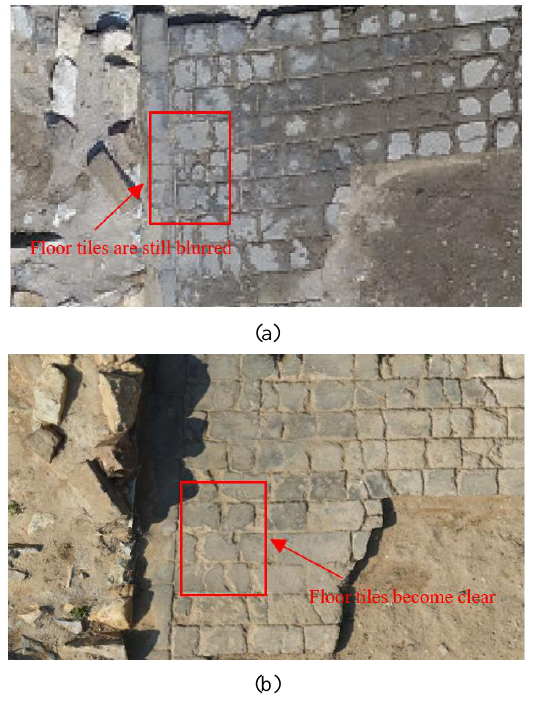
Figure 7. Three-dimensional reconstruction results before(a) and after(b) close-range